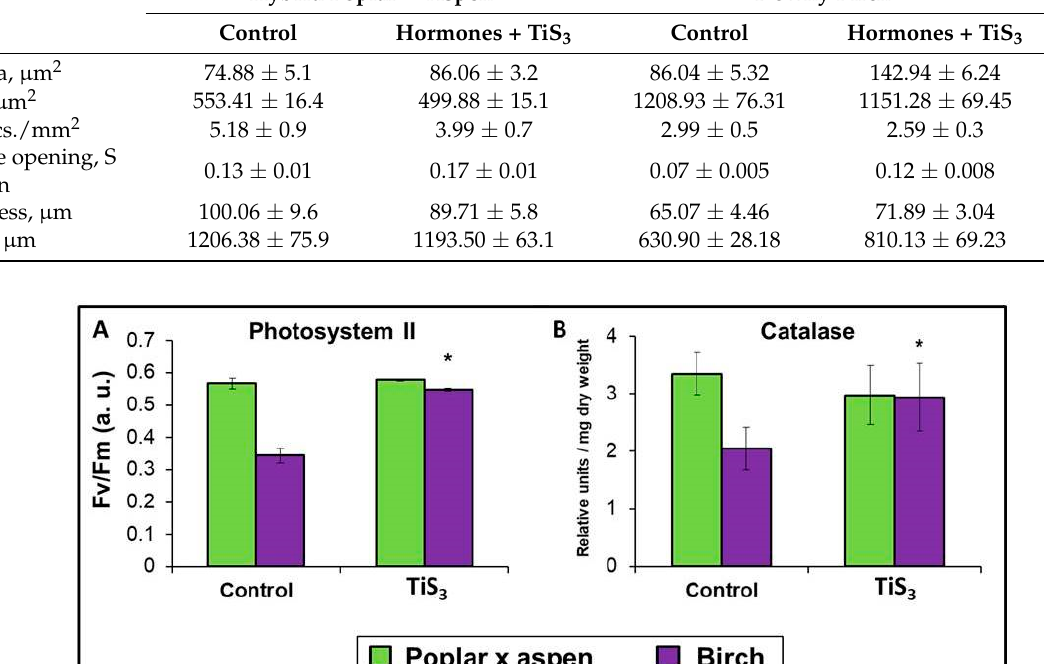
Table 1. TiS 3 effects to the histomorphological parameters of the microclones at the proliferation stage. Parameters